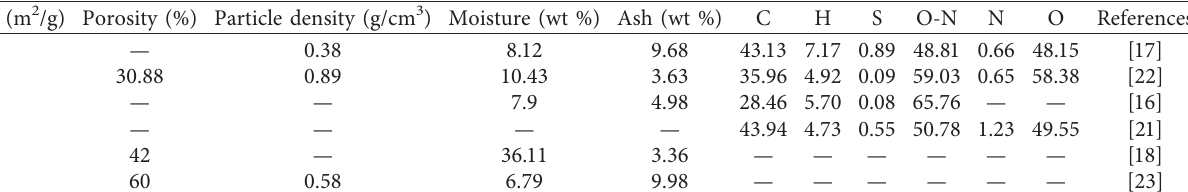
Table 1: Pomegranate peel proximate and ultimate analysis.